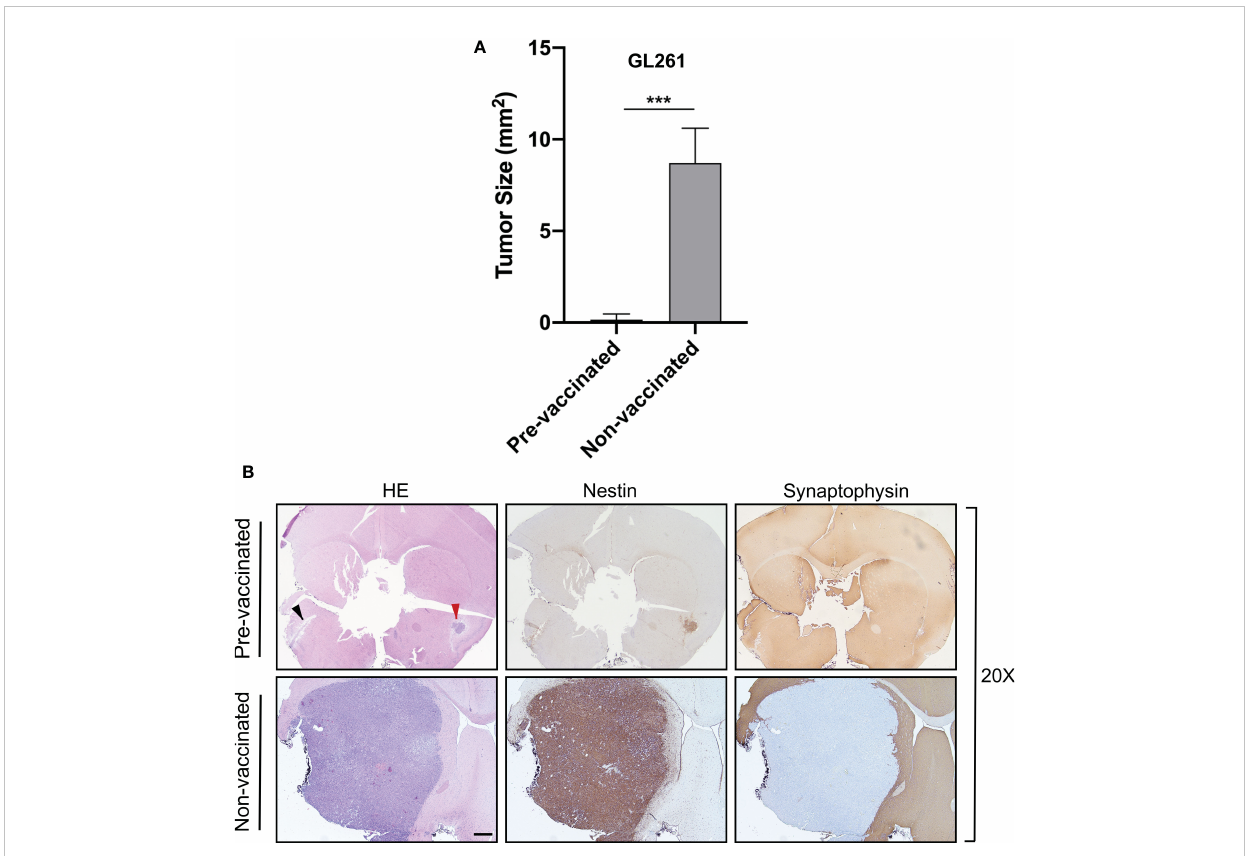
FIGURE 5 Preventive vaccination with GL261-CIITA tumor cells protects the animal against challenge with GL261 parental tumor cells. C57BL/6 mice were intracranially (i.c.) injected with GL261-CIITA cells into the right striatum and after 21 days challenged with parental GL261 tumor cells in the left striatum (pre-vaccinated group). After three additional weeks, animals were sacri fi ced, and their brains were analyzed histologically for presence and size of tumors. As a control, another group of mice were i.c. injected with GL261 cells (non-vaccinated group), and their brains were analyzed after 3 weeks as described in Figure 1. (A) Average size of GL261 tumors in pre-vaccinated and non-vaccinated mice. Bars represent mean values, and error bars indicate the SD of each group, n = 5. p -Values were determined via unpaired t-test; *** p < 0.001. (B) Representative histological sections of the brains harvested from pre-vaccinated (upper panels) and non-vaccinated (bottom panels) mice, at ×20 magni fi cation; scale bar corresponds to 500 m M. Sections were stained with HE or by IHC with nestin- and synaptophysin-speci fi c antibodies to better identify tumoral and non-tumoral tissue, respectively. Arrowheads in the HE-stained section indicate the GL261 parental tumor site (black) and the GL261-CIITA tumor site (red). HE, hematoxylin and eosin; IHC,